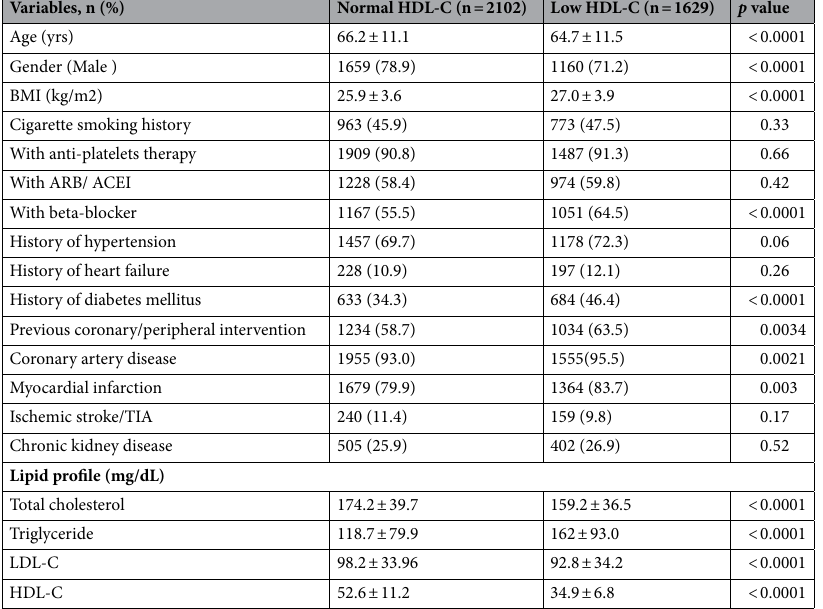
Table 1. Baseline characteristics of patients with normal or low HDL-C. ACEI angiotensin converting enzyme inhibitor, ARB angiotensin receptor blocker, BMI body mass index, HDL-C high-density lipoprotein cholesterol, LDL-C low-density lipoprotein cholesterol, TIA transient ischemic attack.